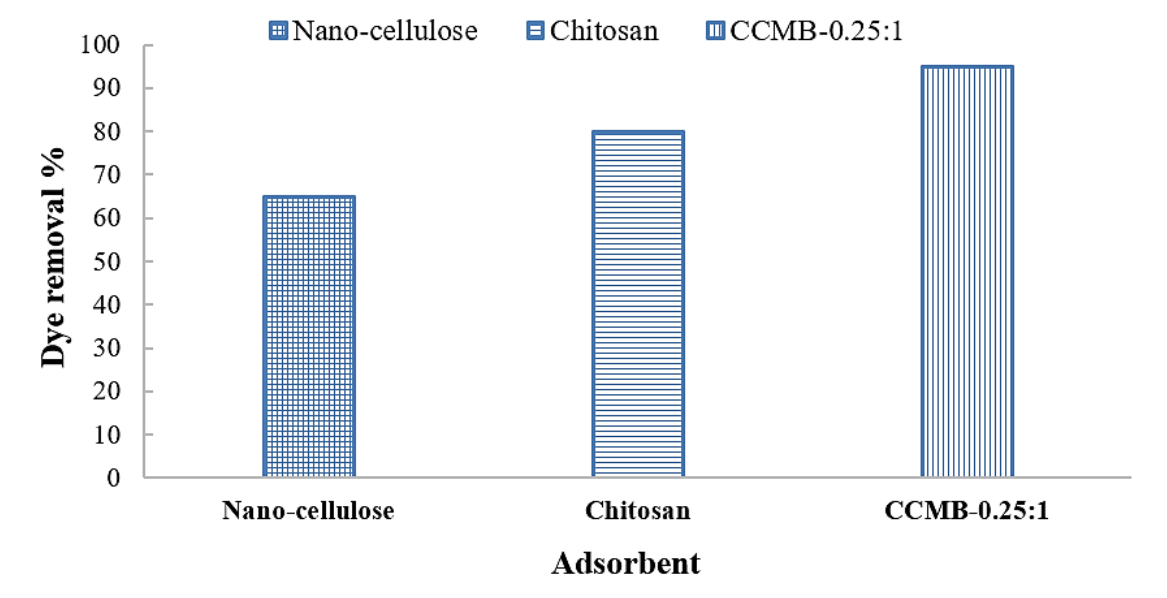
Figure 23. Effect of adsorbent type on dye removal efficiency.